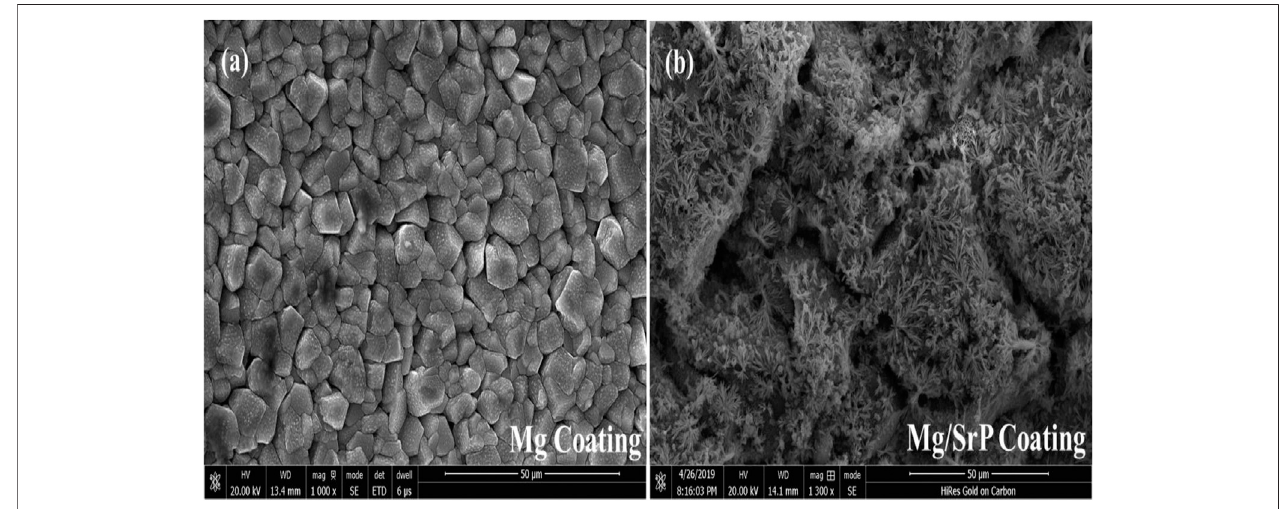
FIGURE 2 | Surface morphologies of the coatings of Mg (A) and Mg/SrP (B) .